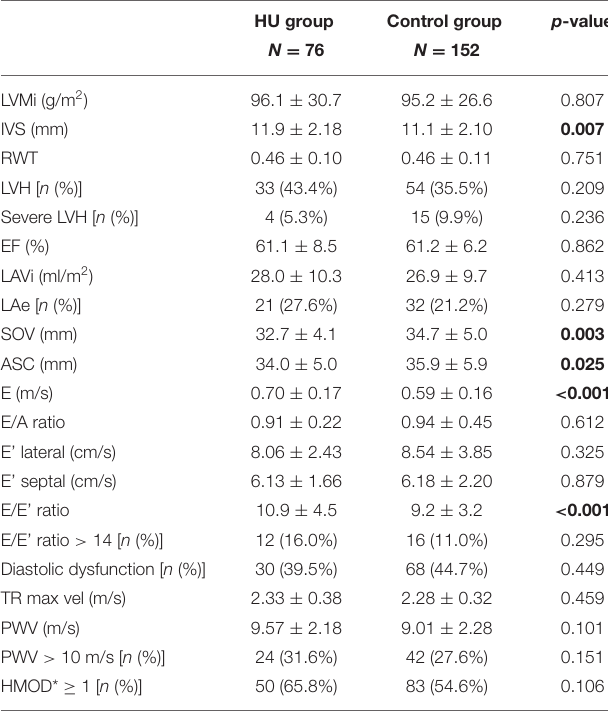
TABLE 3b | Comparison between the HU group and the Control group (echocardiographic characteristics). HU group Control